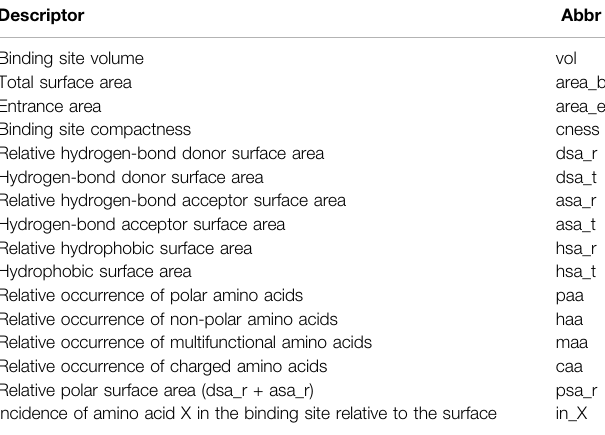
TABLE1| Descriptorsofthedatasets.Theincidenceiscalculatedforeveryamino acid X.